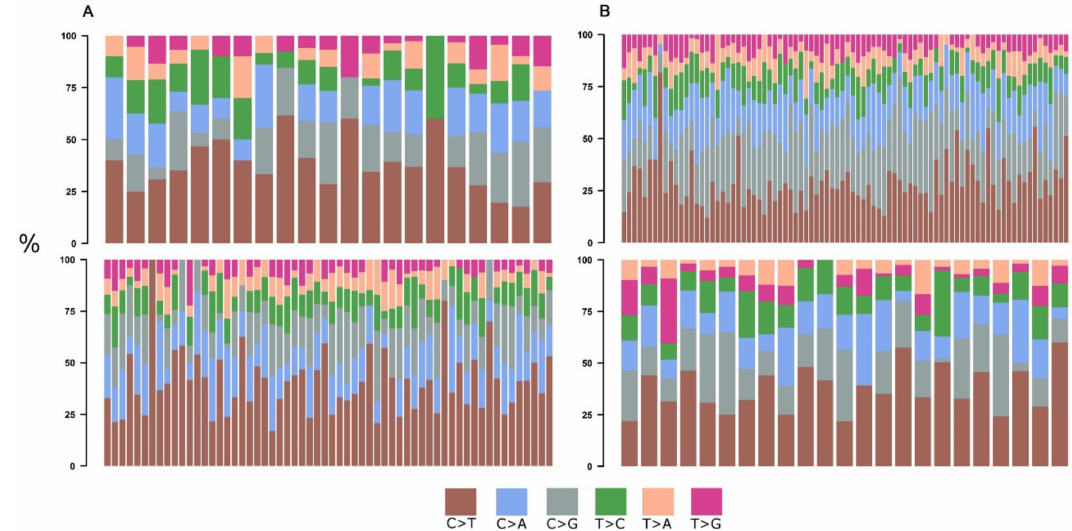
Figure 1. Single base substitutions. ( A ) Distribution of single base substitutions across young ( top ) and elderly ( bottom ) HGSOC patients. ( B ) Distribution of single base substitutions across young ( top ) and elderly ( bottom ) TNBC